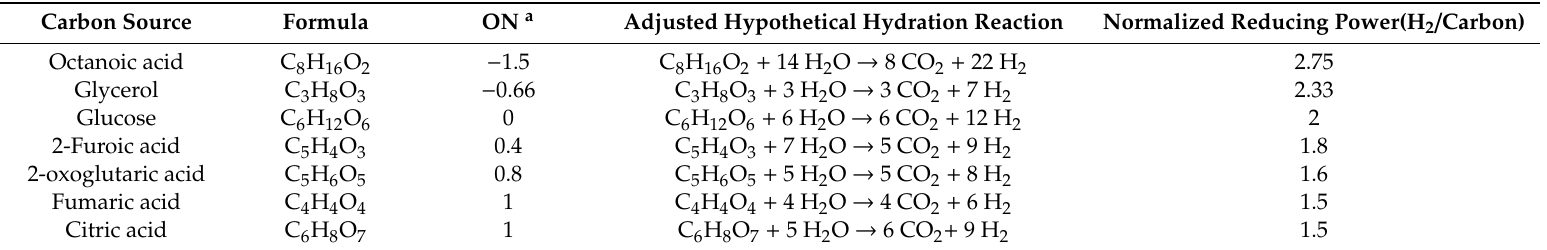
Table 2. Reducing power, expressed as H 2 , of the di ff erent carbon sources used in this